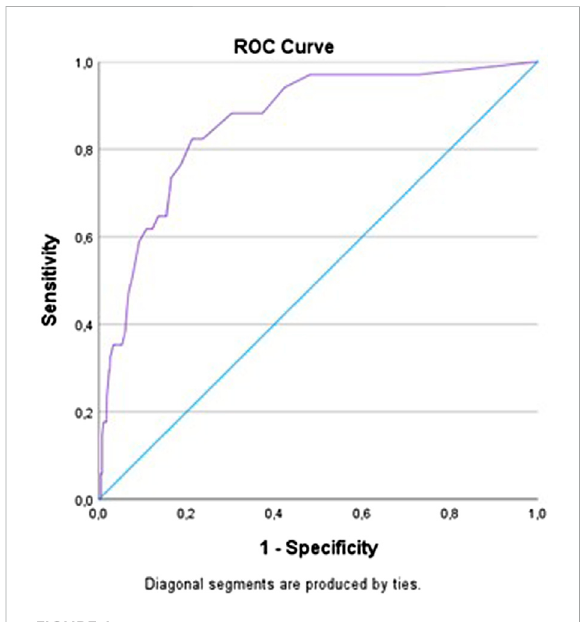
FIGURE 1 ROC curve for anchor question versus adherence score. The ROC curve is produced in